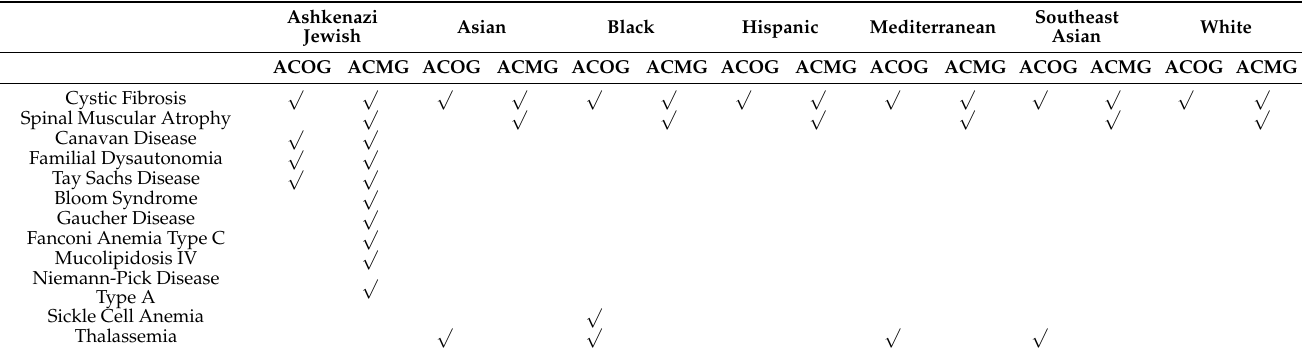
Table 1. American College of Obstetricians and Gynecologists (ACOG) and American College of Medical Genetics and Genomics (ACMG) Single-Gene Carrier Screening Guidelines Prior to 2017